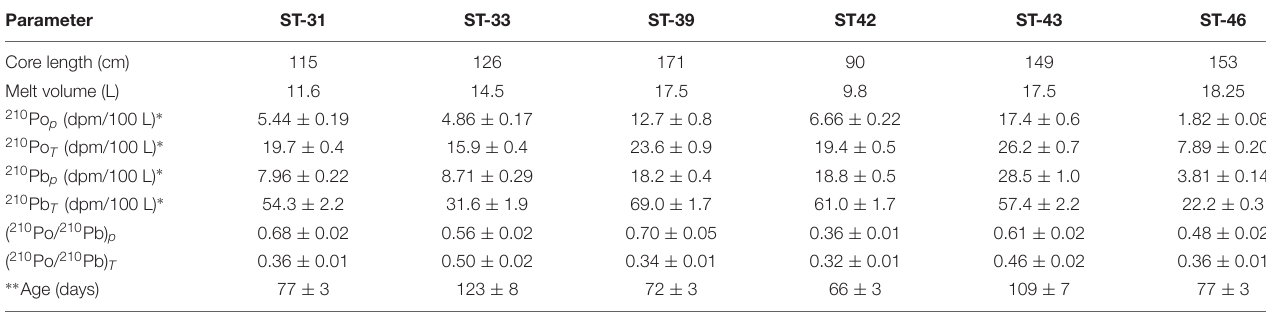
TABLE 7 | Calculated inventory-based particulate (p) and total (T = p + d) activity of 210 Po and 210 Pb and their activity ratio in whole ice core collected during US GEOTRACES Arctic cruise (HLY 1502). Parameter ST-31